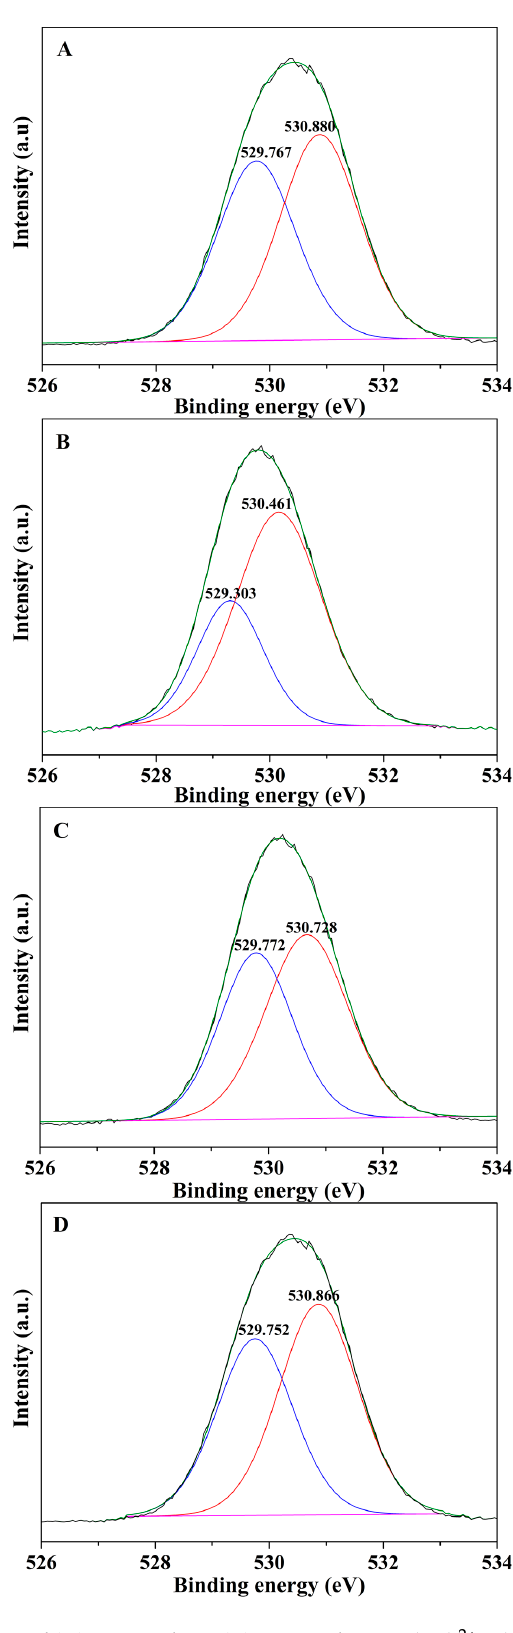
Figure 10. O1s XPS spectra of ( A ) mp-CA/GO, ( B ) mp-CA/GO with Pb 2+ adsorption, ( C ) mp-CA/GO with Cu 2+ adsorption, and ( D ) mp-CA/GO with Cd 2+